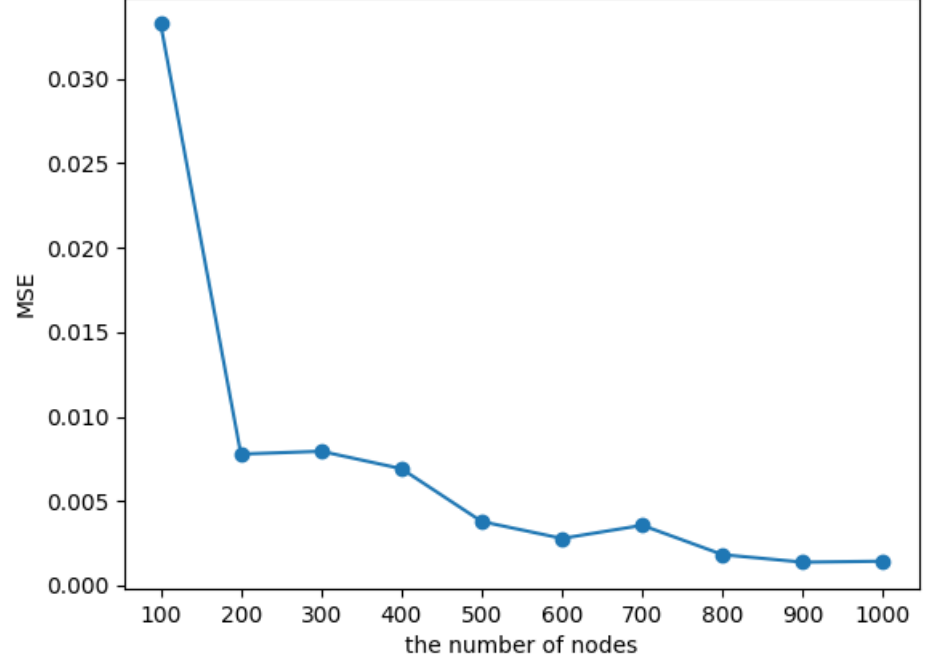
Figure 3. The MSE between eigenvectors of the Laplacian matrix and matrix perturbation